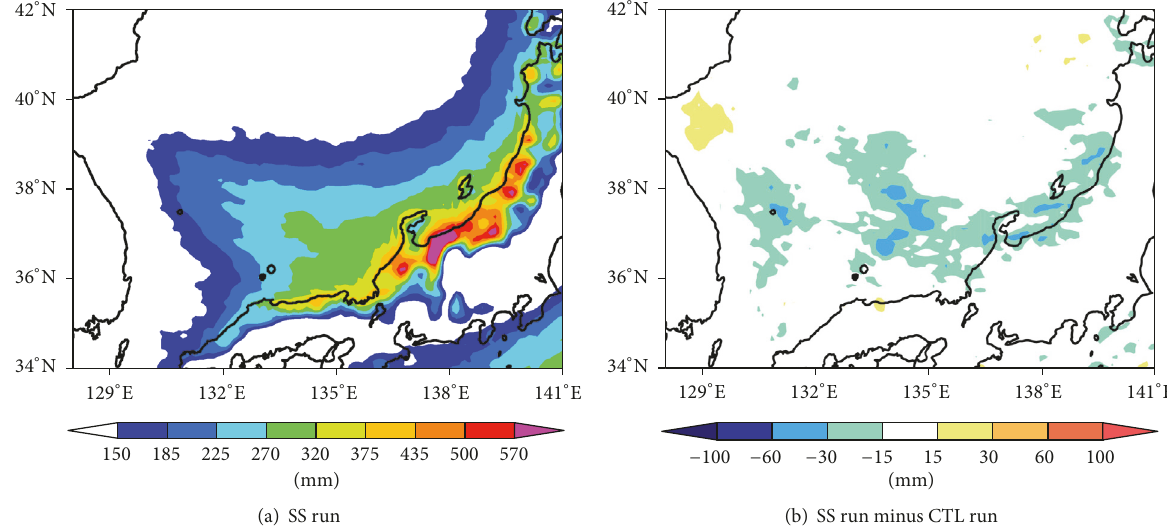
Figure 13: (a) Climatological mean December precipitation during 2000–2014 for the SS run. (b) Difference in precipitation between the SS and CTL runs (former minus